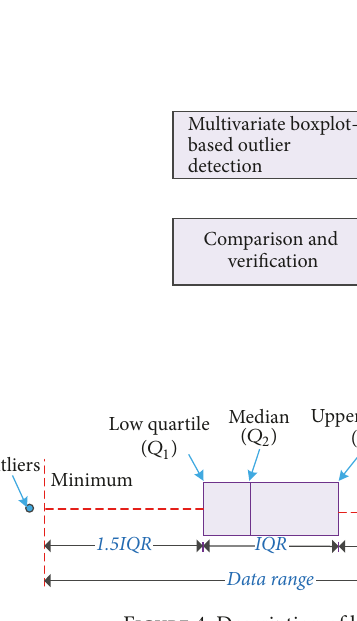
Figure 4: Description of